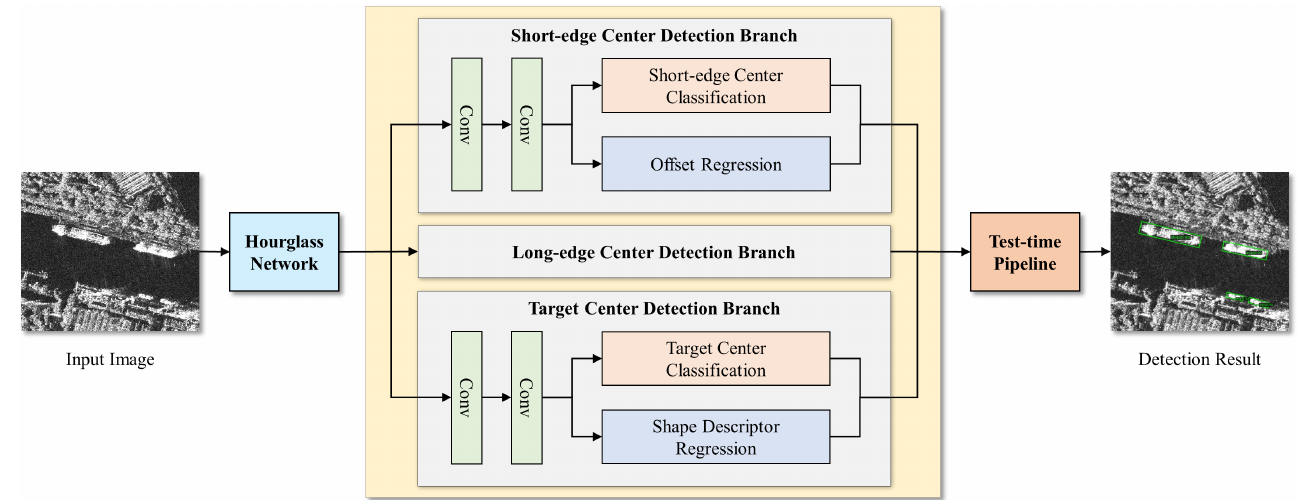
Figure 3. Overview of the proposed KeyShip detection method. The long-edge center detection branch has the same structure as the short-edge center detection branch, and its details are omitted here. The Conv module consists of a sequence of 3 × 3 convolution layer, group normalization layer and Leaky ReLU. Two Conv modules are stacked in each branch to refine the upstream features for the subsequent